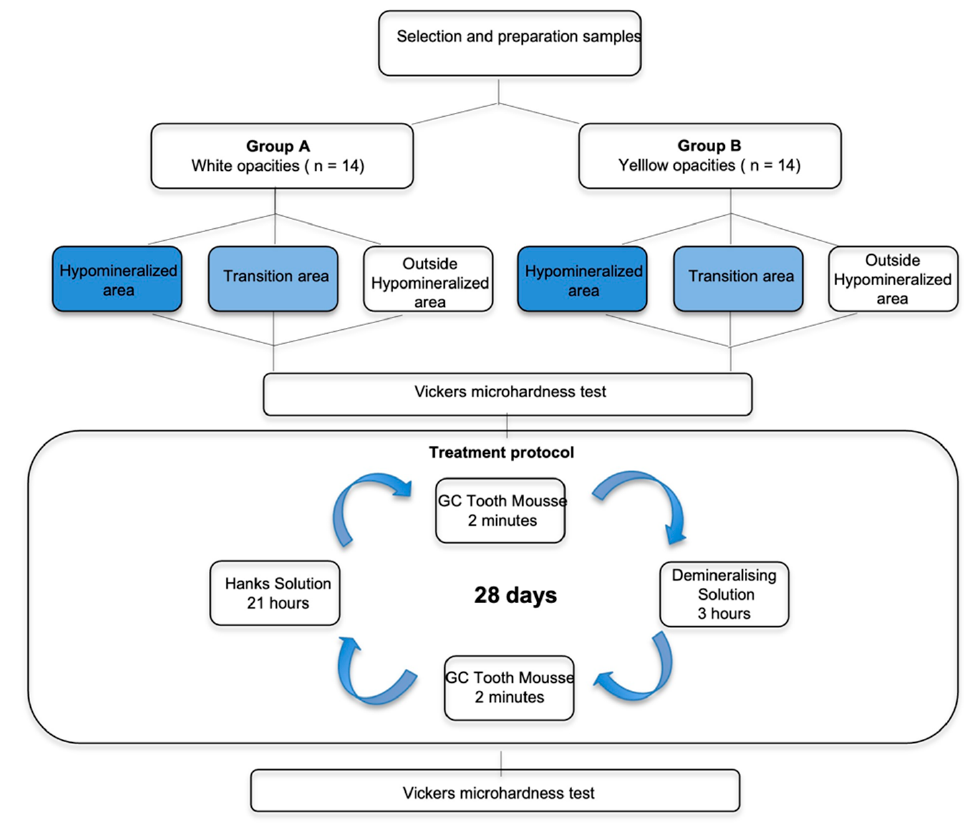
Figure 2. Scheme of the study